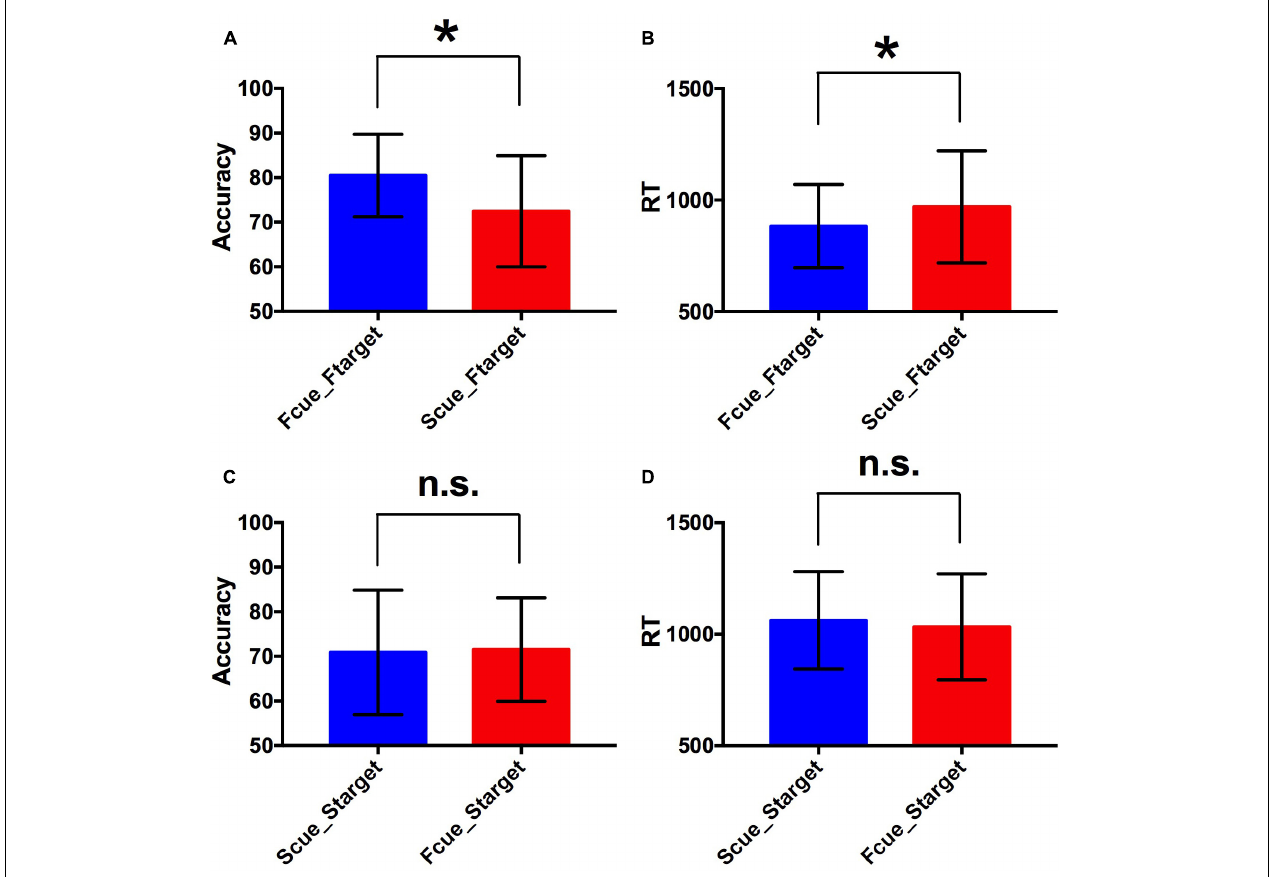
FIGURE 2 | Behavioral performance. (A,B) Comparisons of WM accuracy and RT between Fcue_Ftarget and Scue_Ftarget. By paired two-tailed t -tests, if the target was a face, the accuracy in Fcue_Ftarget was significantly higher and RT was significantly shorter, compared to the corresponding values in Scue_Ftarget ( p = 0.003 and 0.005, respectively). (C,D) Comparisons of WM accuracy and RT between Fcue_Starget and Scue_Starget. If the target was a scene, there were no significant differences of accuracy or RT between groups of different cue types (both p -values > 0.1). The symbols ( ∗ ) and (n.s.) indicate being and not being significant,